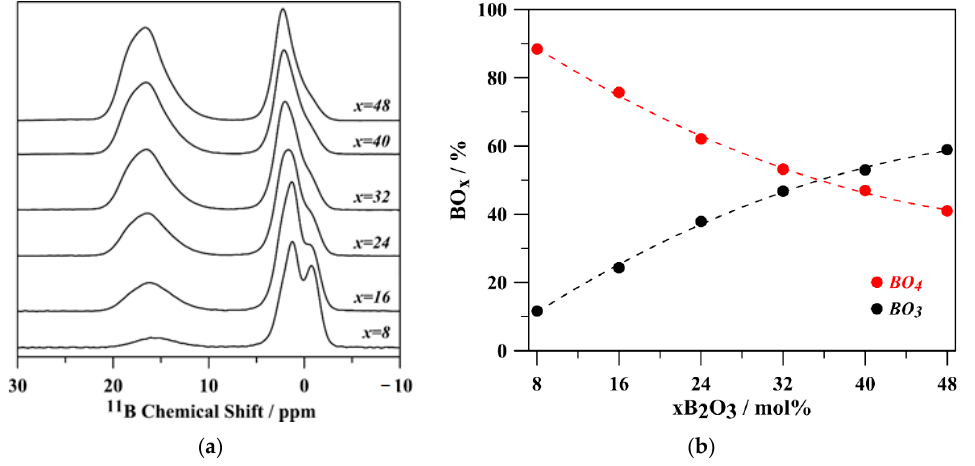
Figure 5. ( a ) The 11 B MAS NMR spectra of the glass series (100 − x)[0.4Na 2 O-0.2Nb 2 O 5 -0.4P 2 O 5 ]- xB 2 O 3 . ( b ) Relative number of BO 4 and BO 3 structural units obtained by the decomposition of 11 B